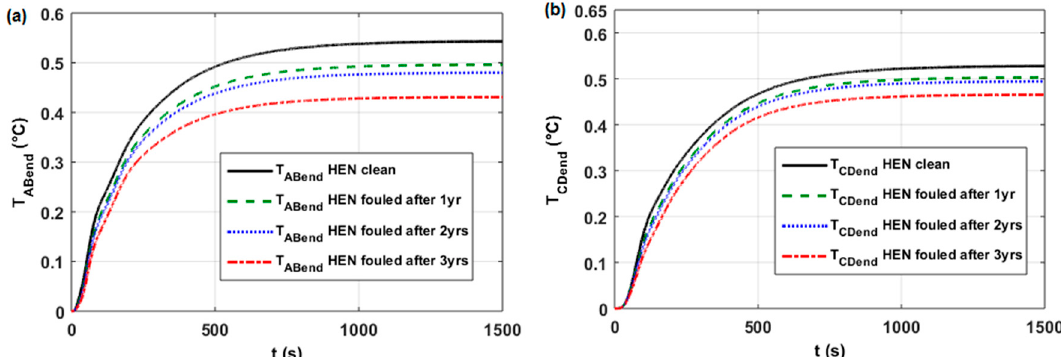
Figure 11. Open-loop responses of the HEN models (( a )—the end temperature T ABend and ( b )—the end temperature T CDend , after parallel branches) to +1 ◦ C step change in the shell-side inlet temperature of selected exchangers.